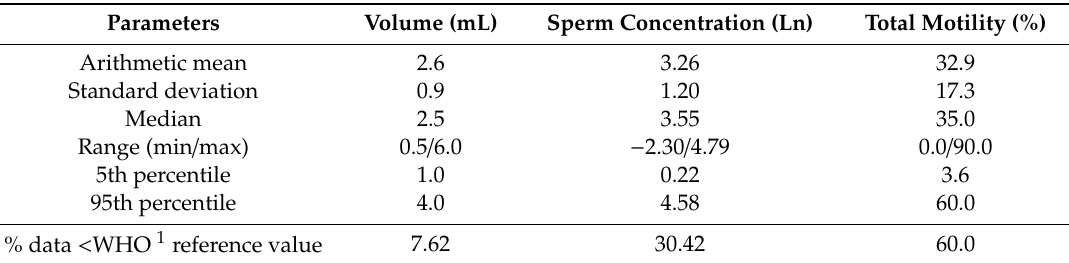
Table 2. Analytical results of seminal liquid parameters.